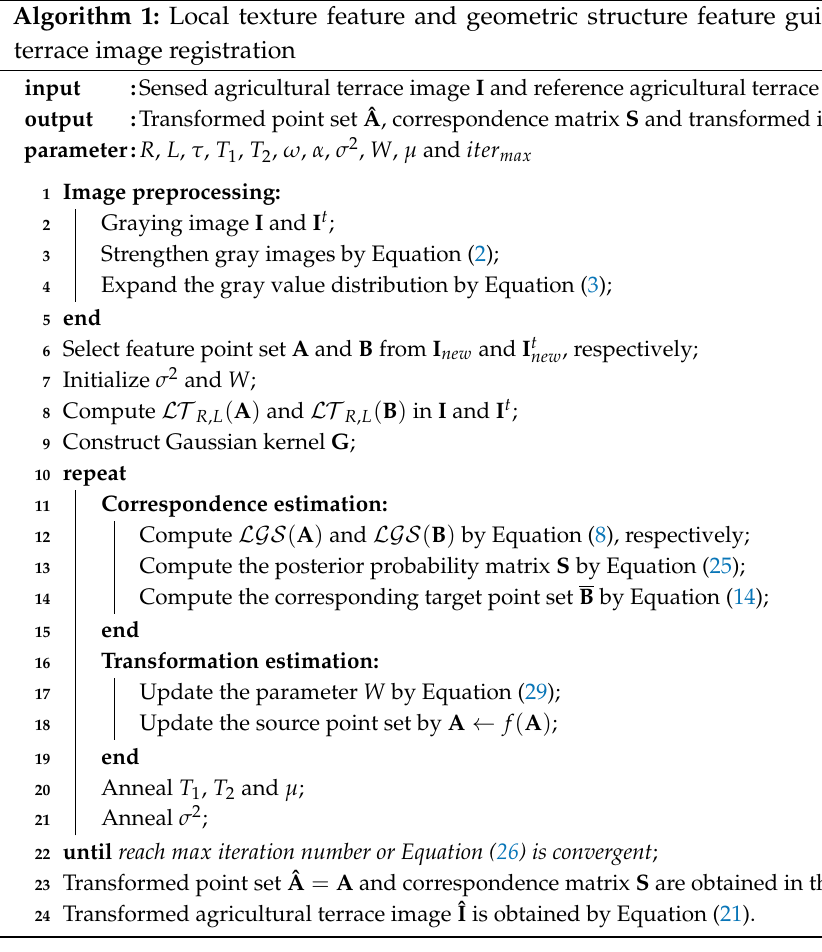
Algorithm 1: Local texture feature and geometric structure feature guided agricultural terrace image